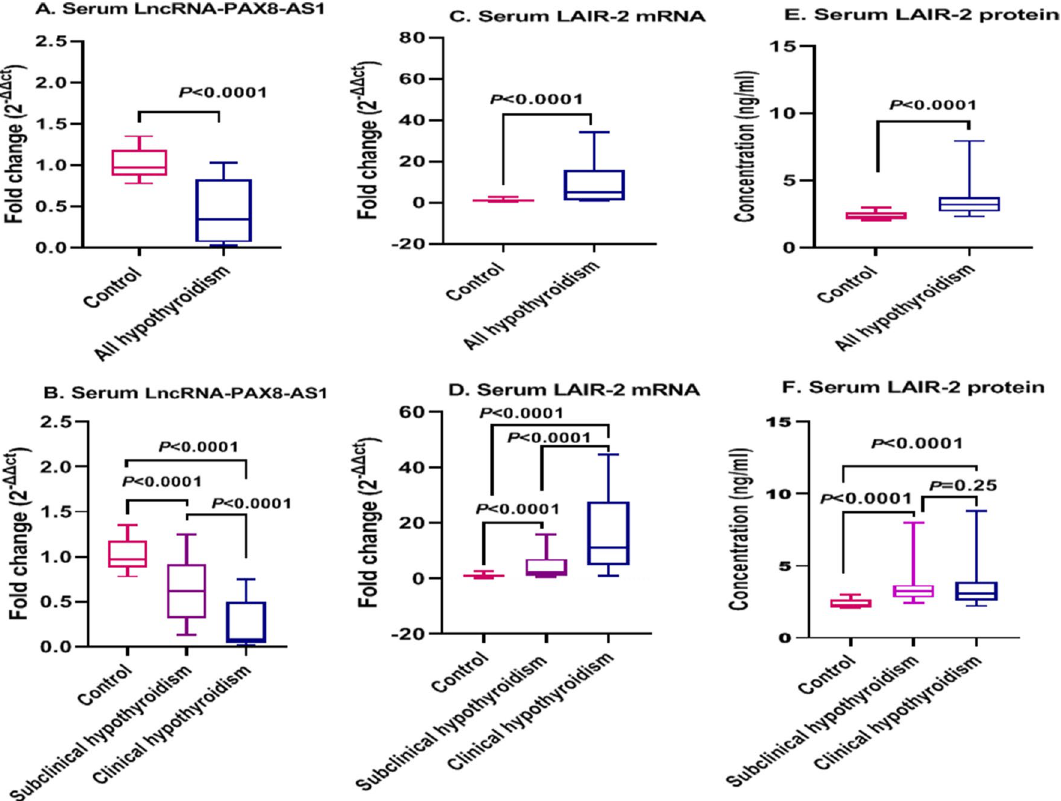
Figure 1. Serum expression levels of LncRNA-PAX8-AS1 and LAIR-2 mRNA and protein in the studied groups. ( A) , ( C) , ( E) all hypothyroidism patients (n = 210) versuss healthy controls (n = 95). ( B ) ( D ), ( F ) Clinical hypothyroid patients (n = 100) and subclinical hypothyroid patients (n = 110) versus healthy controls (n = 95). Data are expressed as box blot; the box represents the 25–75% percentiles; the line inside the box represents the median and the upper and lower lines representing the 10–90% percentiles. P < 0.05 means statistical